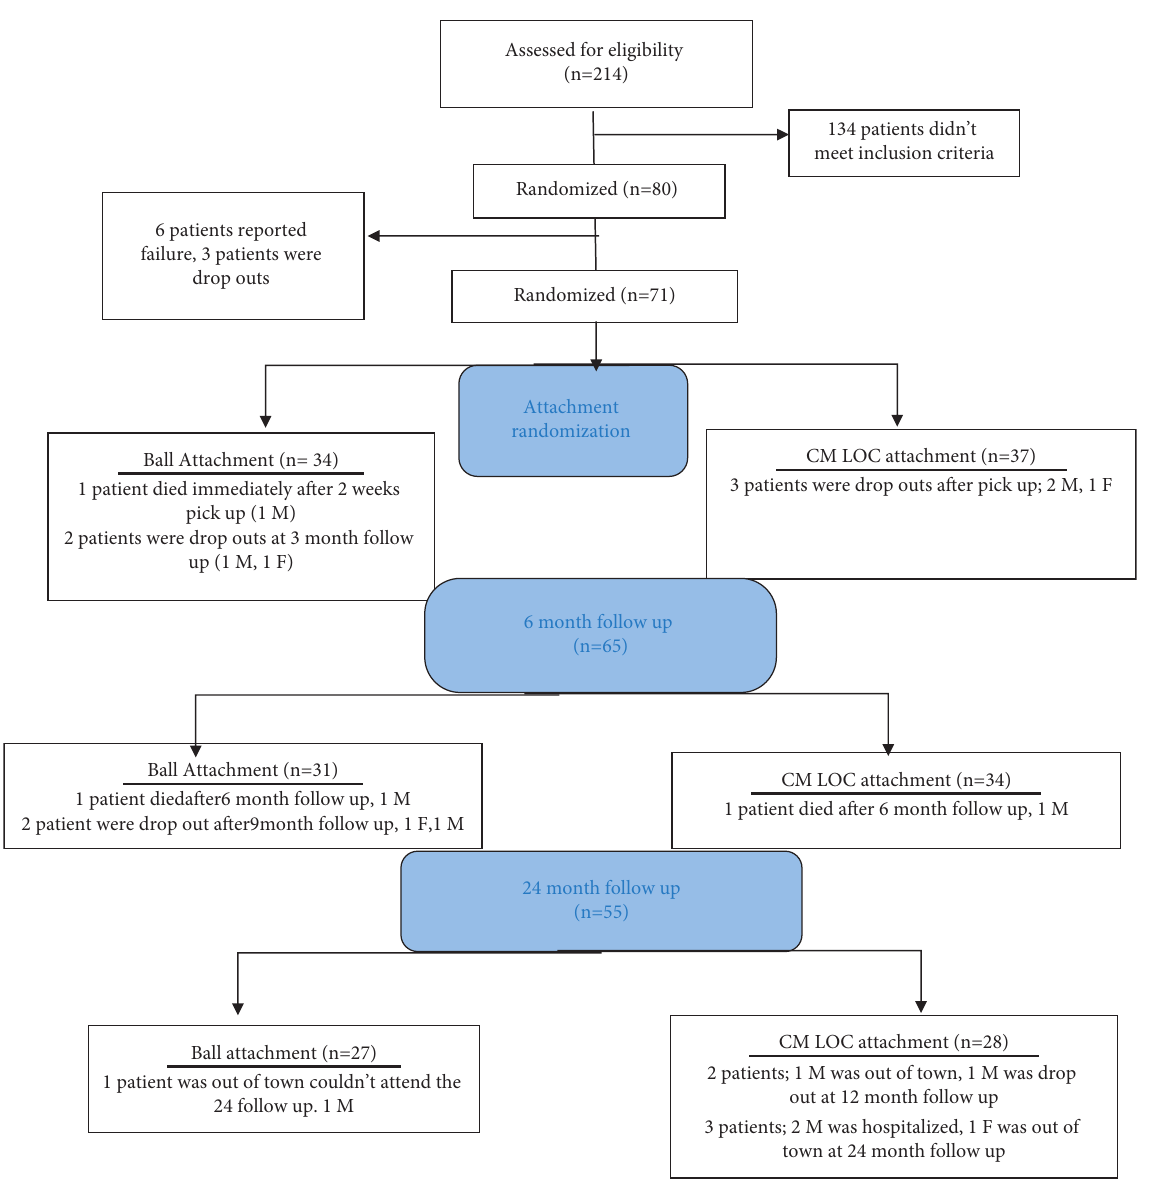
Figure 2: Consort flow diagram showing dropouts and including patients throughout the 24-month follow-up period (M: male; F: